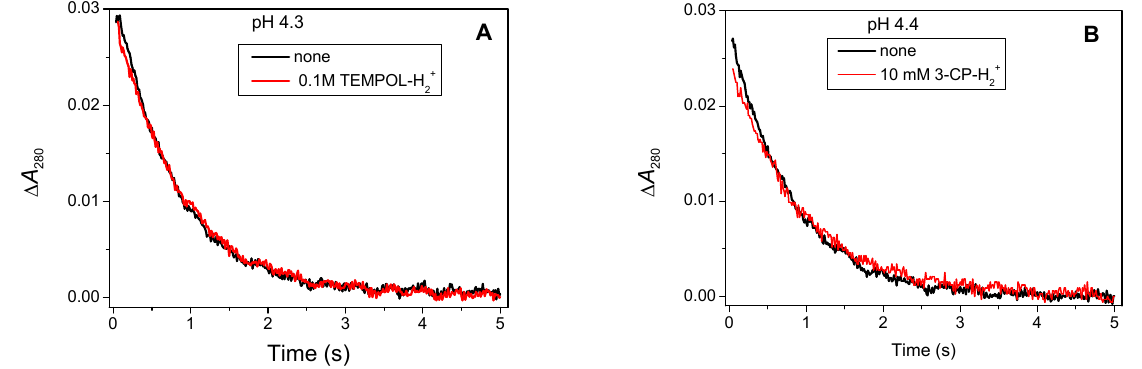
Figure 1. Reaction of ONOOH with RN + HOH. Absorbance changes ( ∆ A 280 ) observed when ( A ) 135 µ M peroxynitrite decayed at pH 4.3 in the absence (black curve) and presence of 0.1 M TEMPOL-H 2+ (red curve); ( B ) 120 µ M peroxynitrite decayed at pH 4.4 in the absence (black curve) and presence of 10 mM 3-CP-H 2+ (red curve). Solutions contained 50 mM acetate buffer and 50 µ M DTPA. In the presence of 0.625 mM and 1.25 mM TEMPONE-H 2+ , k d increased somewhat to 1.43 ± 0.03 s − 1 and 1.63 ± 0.09 s − 1 , respectively. Further increase of [TEMPONE ‐ H 2+ ] to 2.5 mM had no effect on the rate, i.e., k d = 1.58 ± 0.07 s − 1 .